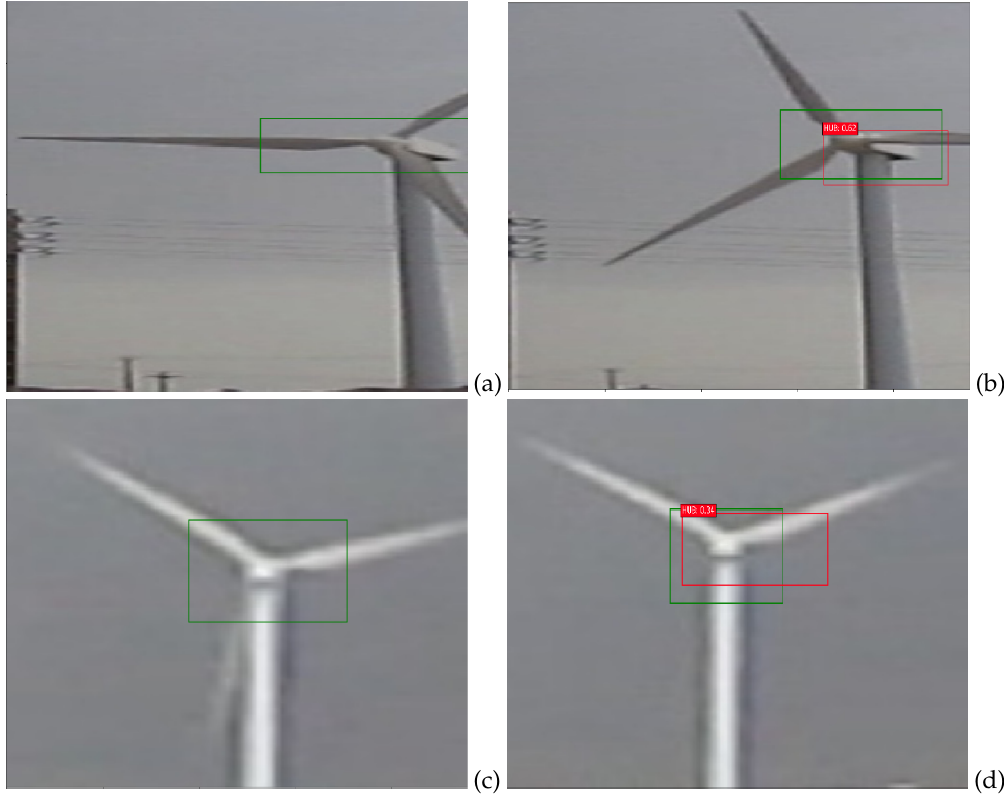
Figure 12. Solving false negative detection problem. ( a , c ) False negatives with epoch =10, confidence thresh = 0.70, IoU = 0.50. ( b , d ) True positives with epoch = 10, confidence thresh = 0.3, IoU = 0.50 (with NMS)